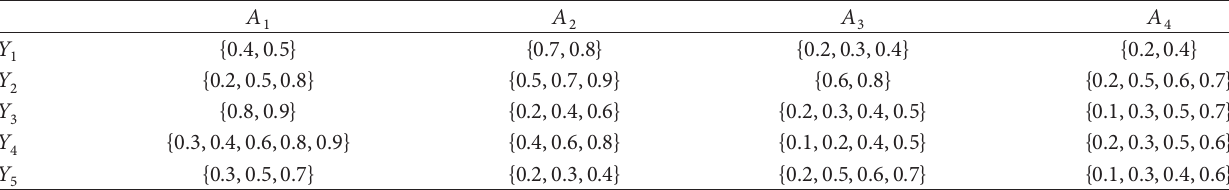
Table 1: Hesitant fuzzy decision making